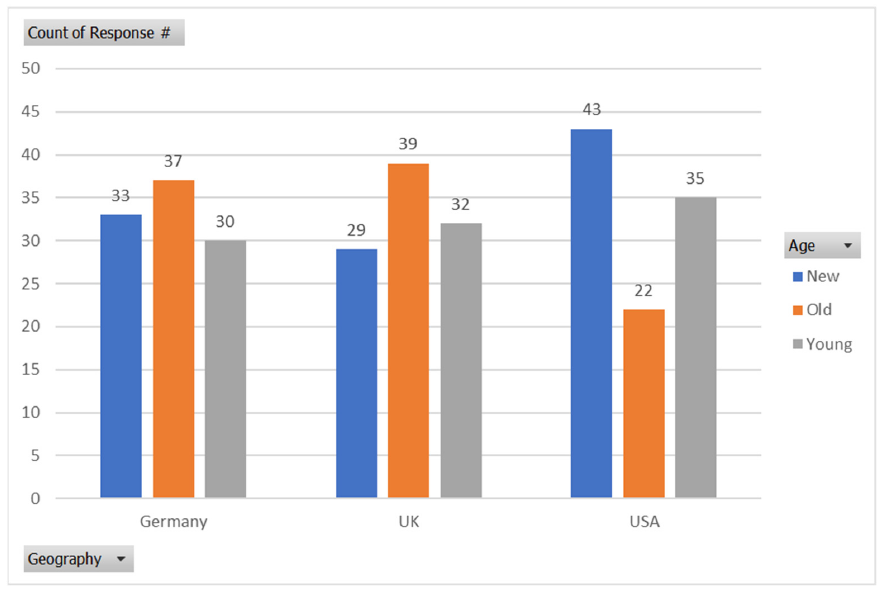
Figure 1. Age of the company by country.